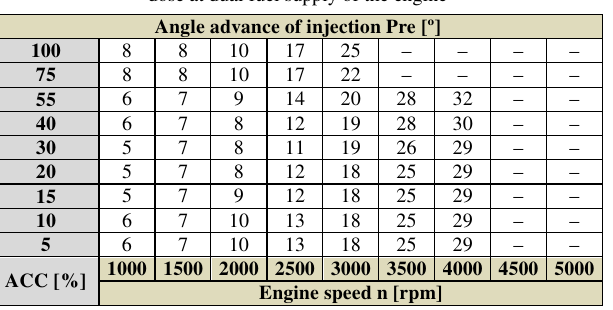
Table 9. Control algorithm of opening time of CNG gas injectors at dual fuel supply of the engine